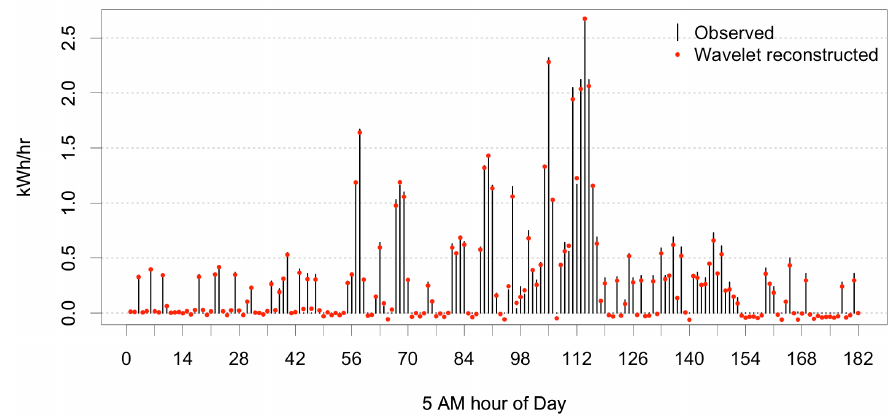
Figure 7. A WARM-based curve fit of 5 a.m. hourly energy usage of DHW heater in RBSA home 10388 from Q2 2012–Q3 2012 inclusive. Prediction errors in the ON state are depicted by the vertical offset between the observed value at the top of each bar and its corresponding wavelet reconstructed value denoted as a red dot; errors in the OFF states include non-zero values viewed along the